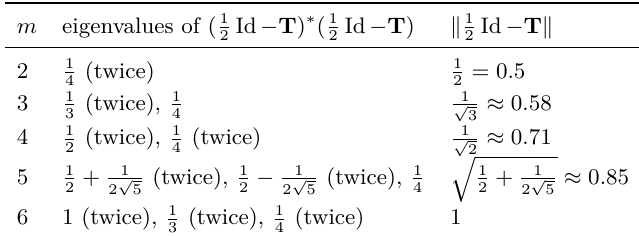
Table 1 Computing the operator norm of